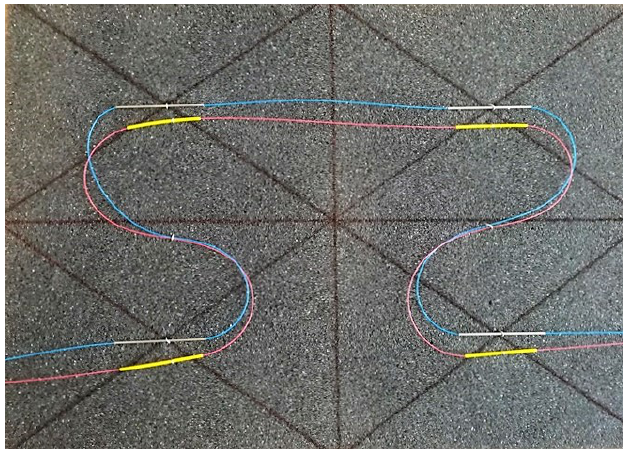
Figure 2. Model of the meander for strain and temperature